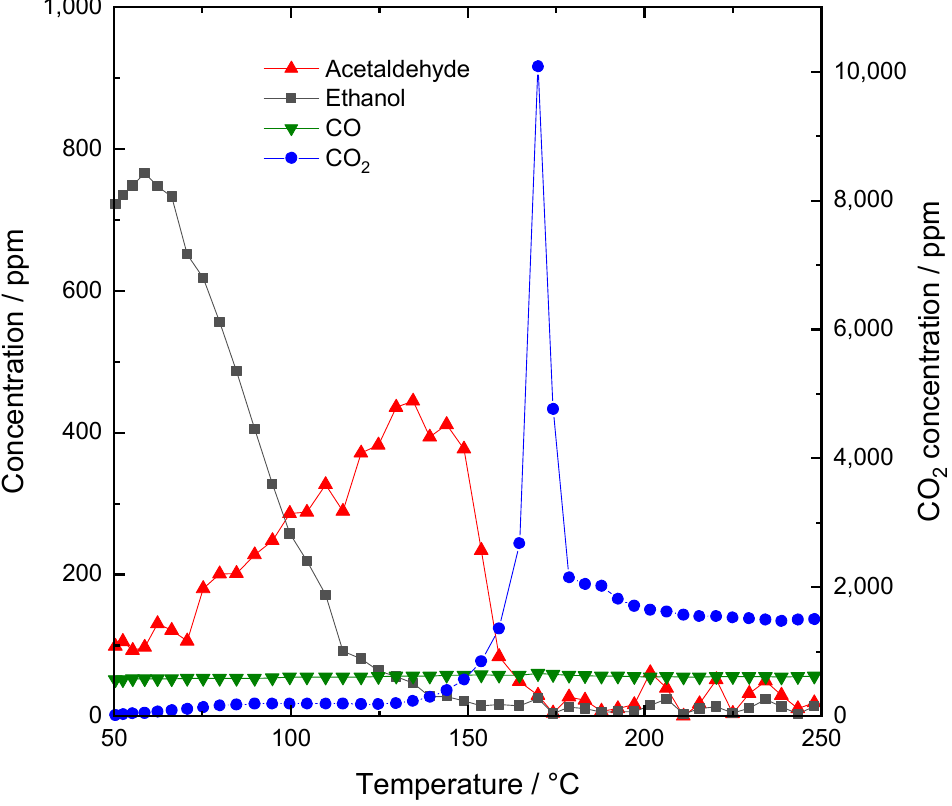
Figure 8. Concentration profiles of ethanol, acetaldehyde, carbon monoxide, and carbon dioxide during the light-off experiment over the CoCu41 catalyst.